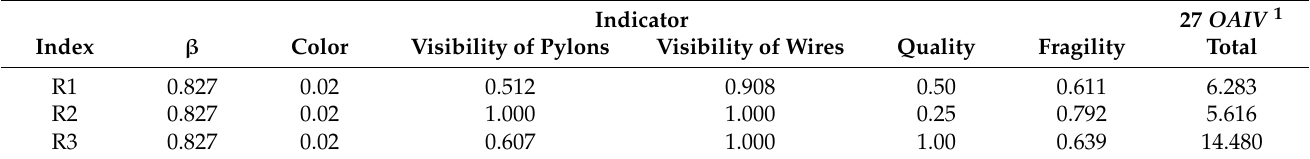
Table 13. The evaluation result of the proposed methodology.